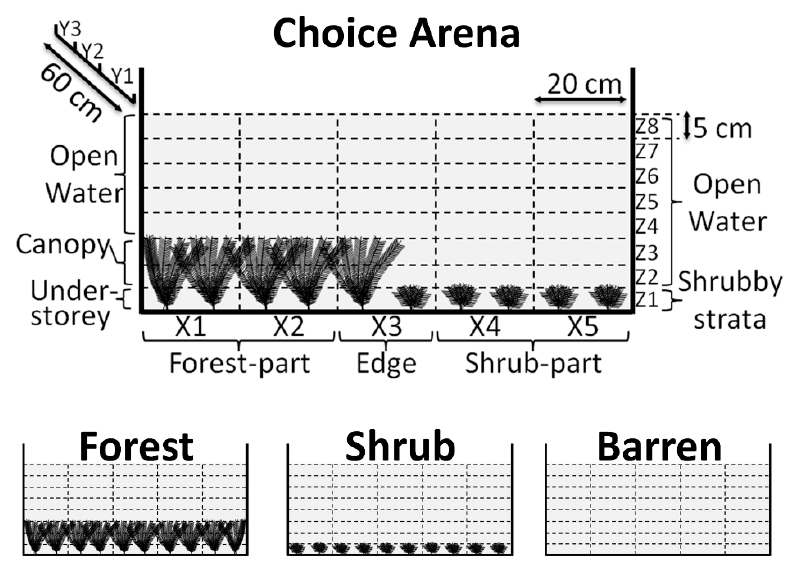
Figure 1. Schematic representation of the 3 artificial habitat types and the choice arena. Tanks were 100 × 60 × 40 cm and virtually divided by a 3D grid (X, Y and Z axis) for recording fish positions. Stems of plastic algae were used for mimicking vegetation (see also Figure S3 showing pictures of artificial set up).